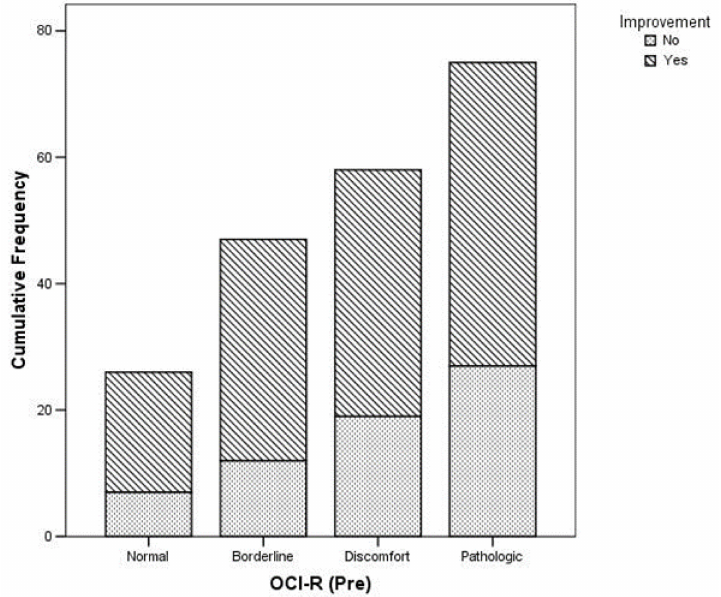
Figure 2. Relationship between OCI-R at T0 and clinical improvement ( p = 0.002).